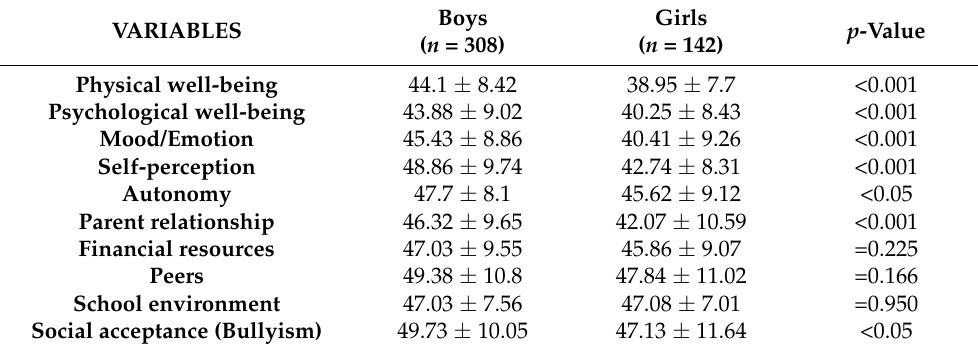
Table 3. Gender differences in KIDSCREEN-52 domains.